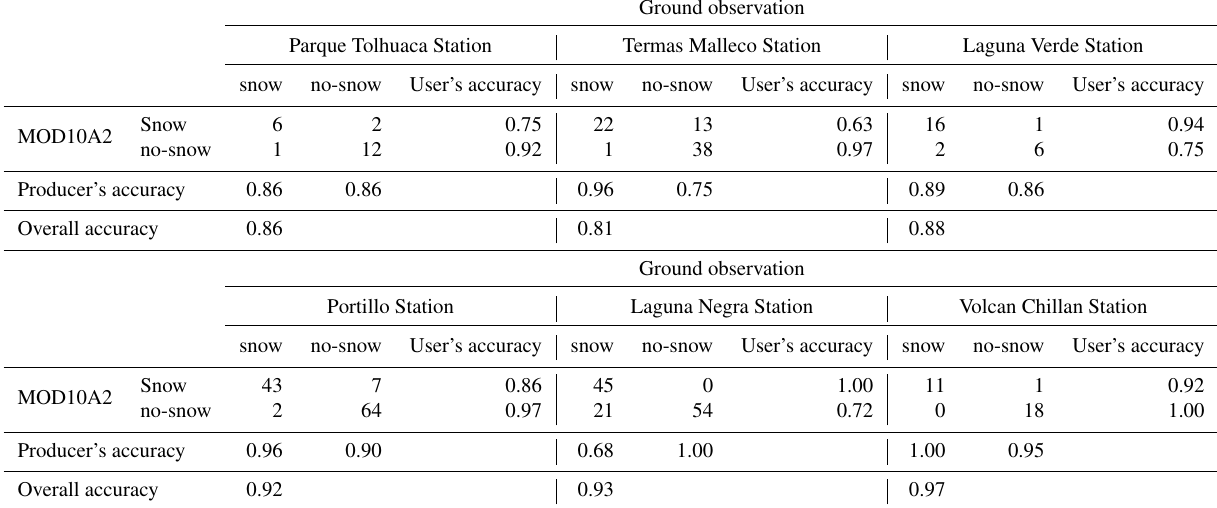
Table 3. Confusion matrix and indexes of agreement for Parque Tolhuaca, Termas Malleco and Laguna Verde stations. Ground observation Parque Tolhuaca Station Termas Malleco Station Laguna Verde Station snow no-snow User’s accuracy snow